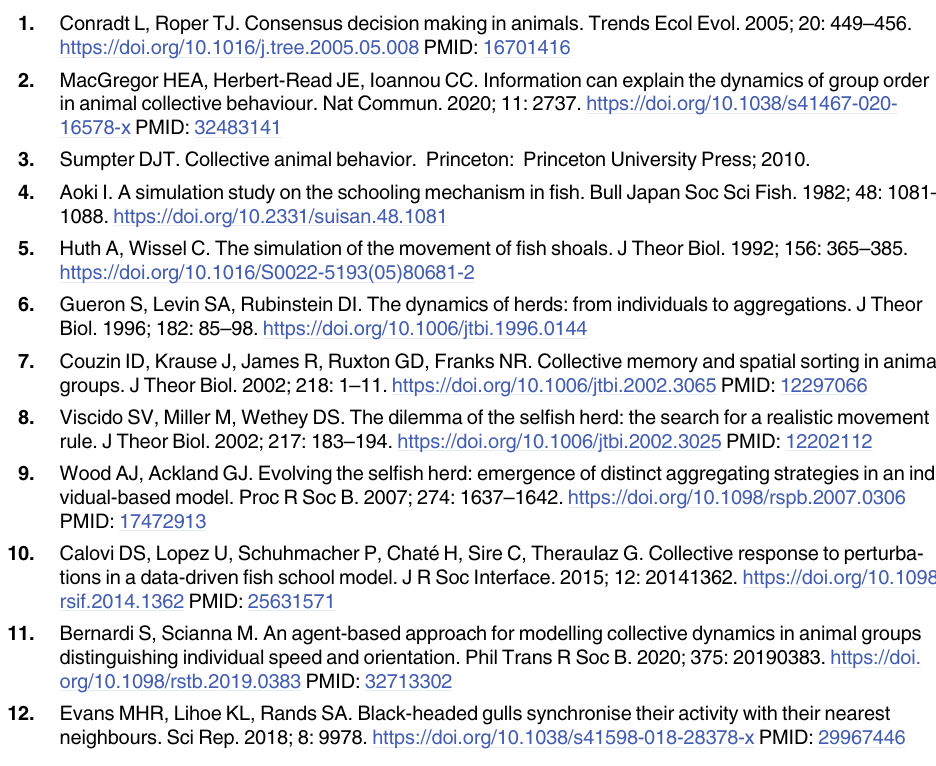
on group performance when food